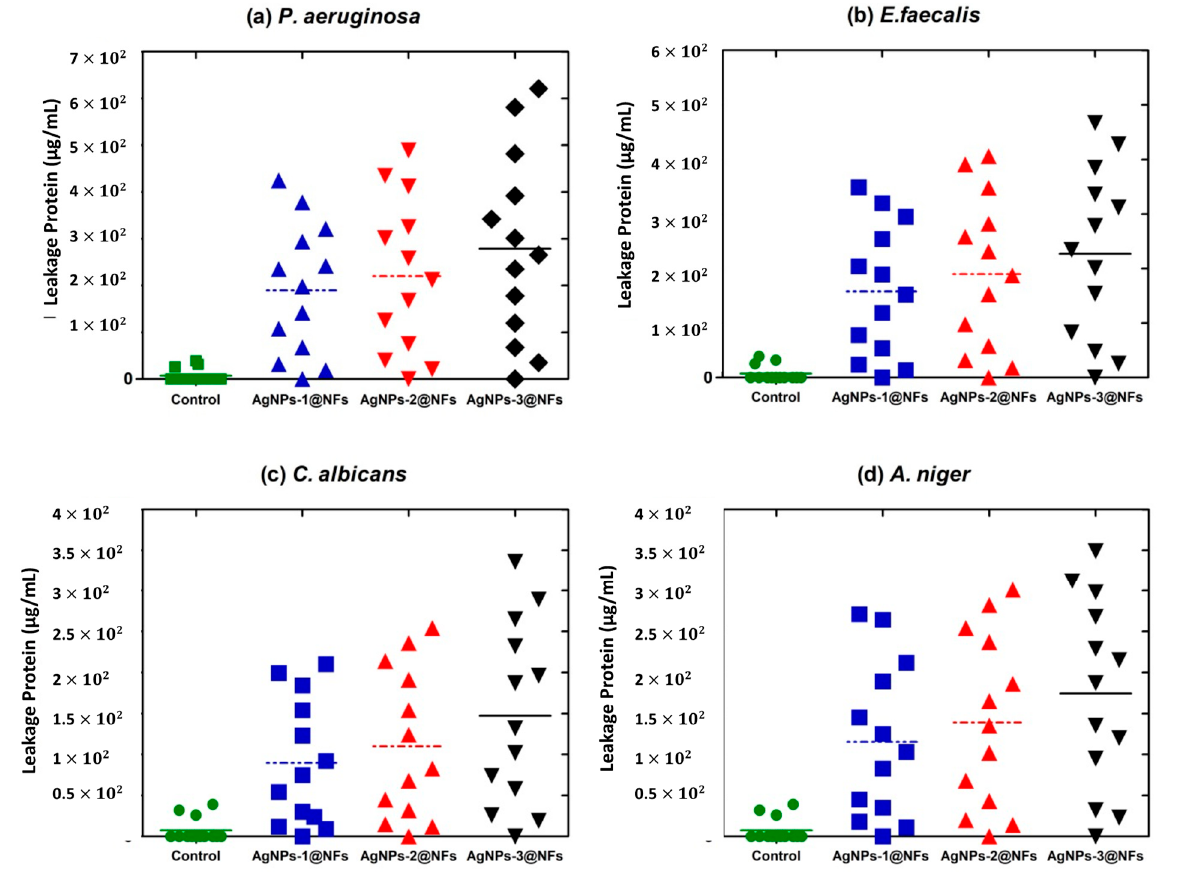
Figure 13. The perceived amounts of protein leakages of protein of ( a ) P. aeruginosa , ( b ) E. faecalis , ( c ) C. albicans , ( d ) A. niger treated with three nanofibers (AgNPs-1@NFs, AgNPs-2@NFs, and AgNPs-3@NFs) within 2–24 h. The obtained values epitomize the mean ± SD of triplicate trails.